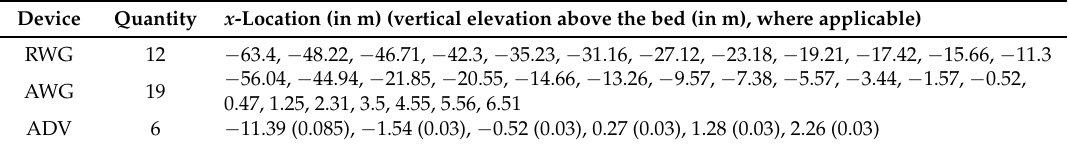
Table 3. Instrument locations and vertical elevations above the bed at the start of the first run of case1. Device